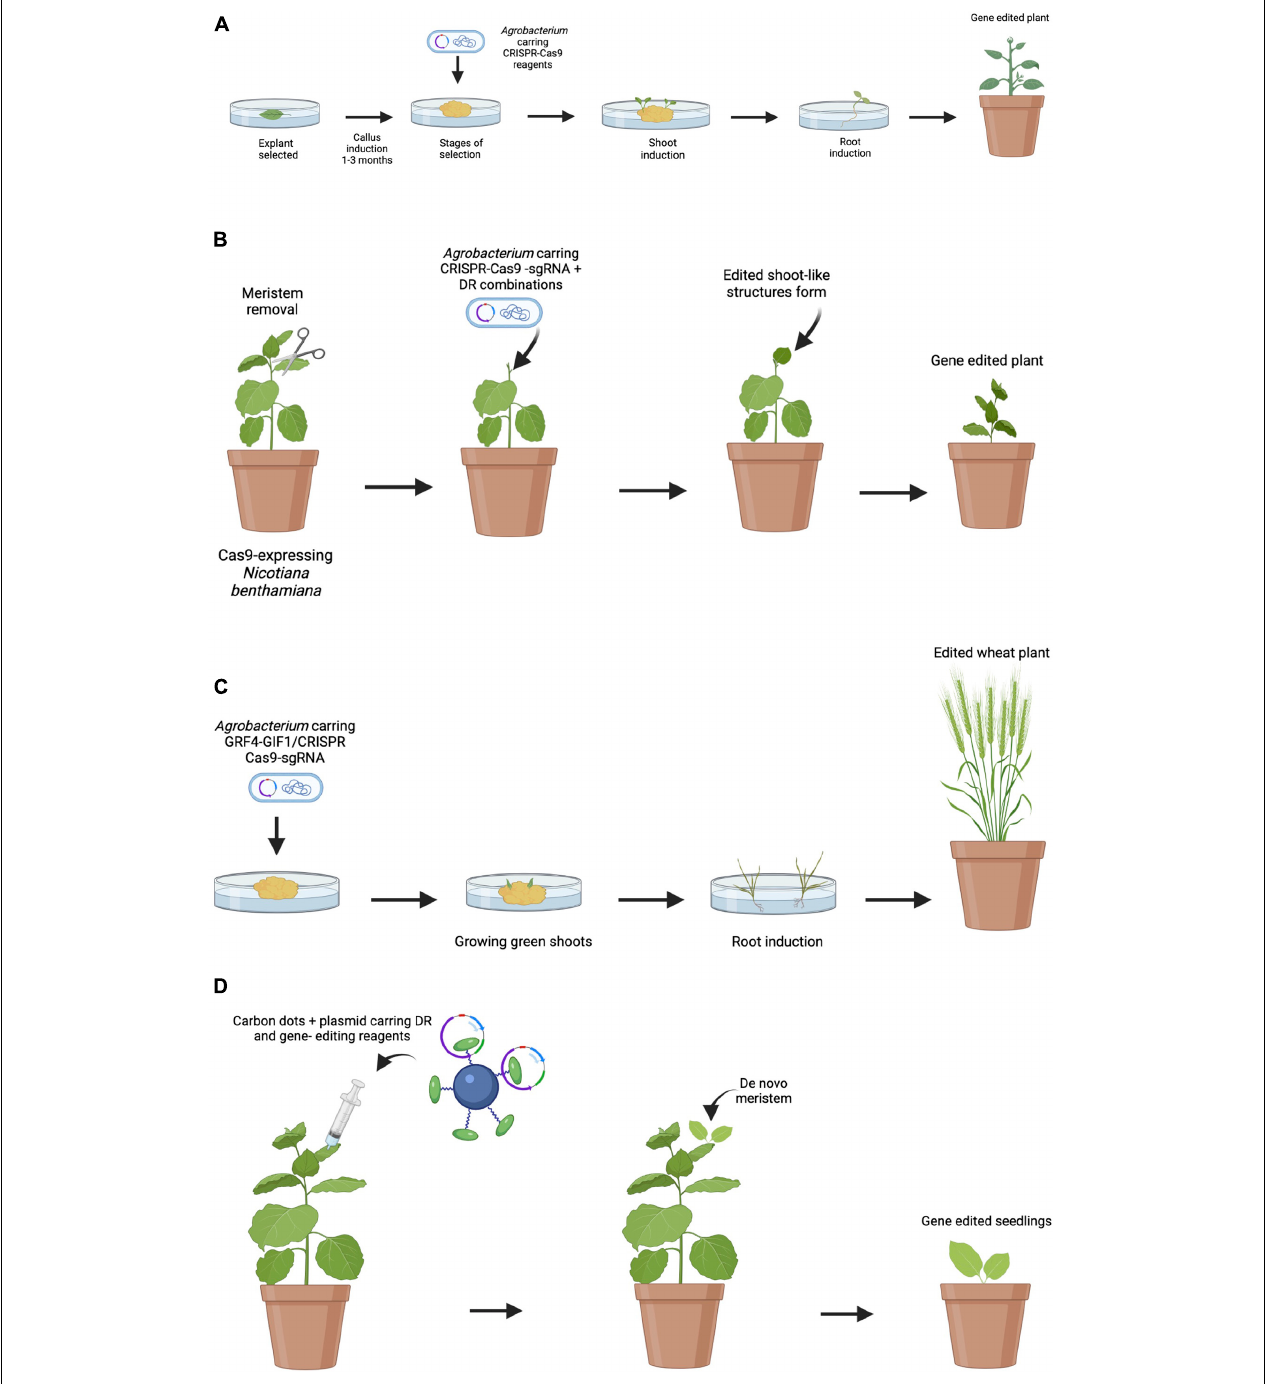
FIGURE 1 | Comparison of traditional and emerging transformation and edition techniques. (A) Traditional Agrobacterium -mediated embryo transformation. Embryos are obtained and then incubated with A. tumefaciens . Multiple steps of selection are done to identify transgenic callus. Selected calli are transferred to shoot induction media follow by root induction media. Finally, plants are transferred to soil. (B) Induction of transgenic shoots on soil-grown plants. Meristems are removed, and DRs and gene-editing reagents are delivered by A. tumefaciens . After a while, de novo gene-edited shoots are formed and editing events are transmitted to the next generation. (C) Induction of edited shoots using the GRF–GIF chimera. GRF4–GIF1/CRISPR–Cas9–gRNA construction is delivered by A. tumefaciens . As a result, an increase in regeneration efficiency is observed. The shoots are then transferred to a medium to root and develop into whole plants. (D) Proposed model for nanoparticle mediated CRISPR/Cas9 in plant engineering. Nanoparticles can deliver DR and CRISPR/Cas9 reagents into plant cells, resulting in transgenic plants through de novo induction of meristems.